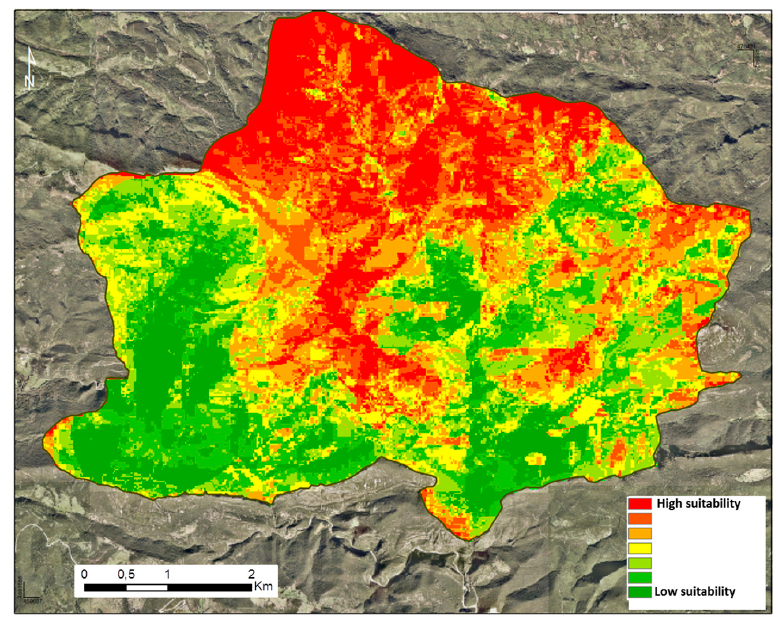
Figure 5. Suitability map according to the conservation matrix (Scenario 1).